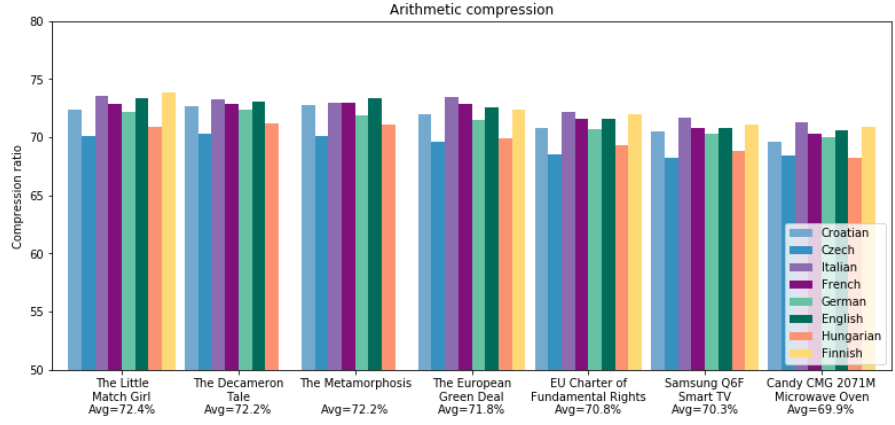
Figure 10. Arithmetic compression